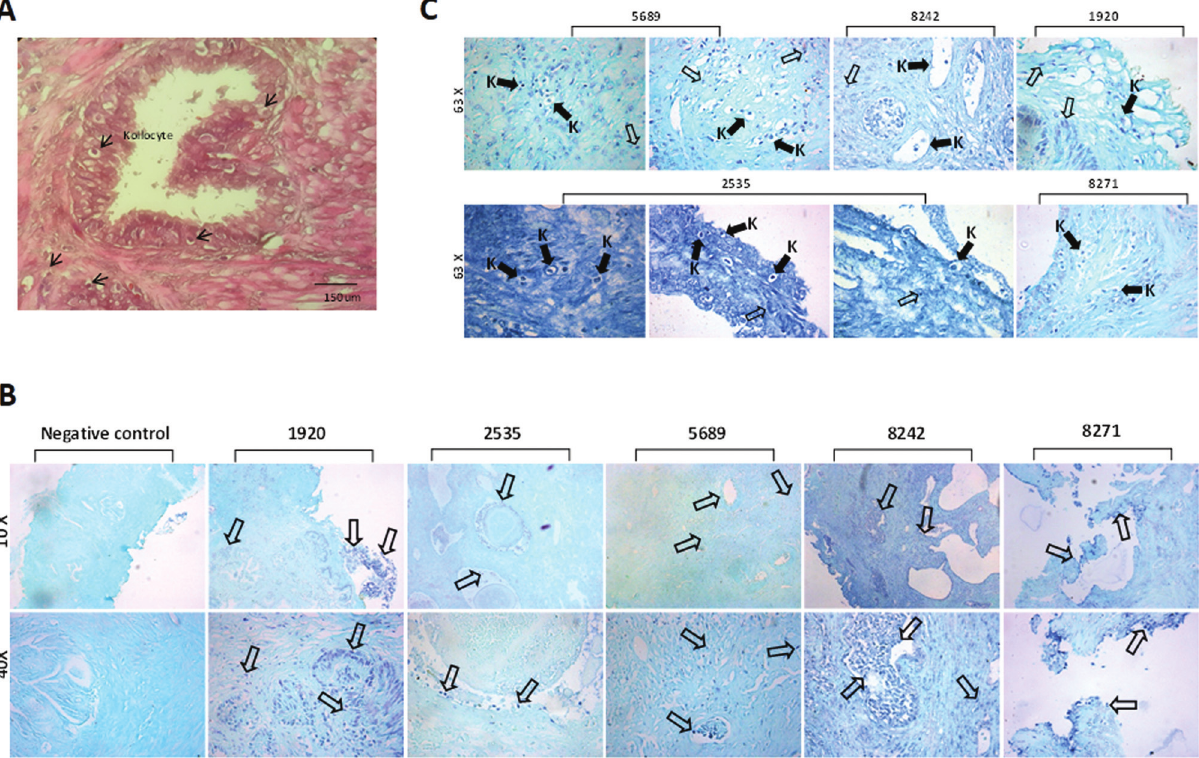
Figure 2 - Histopathological and molecular analysis of prostate cancer tissues. (A) Koilocytes were observed in several HPV-infected prostate cancer tis- sues. Arrows indicate the koilocytes in a representative image. (B) In situ HR-HPV detection. HR-HPV E6/E7 DNA was detected in prostate cancer sec- tions employing in situ PCR as indicated in the Materials and Methods. The signal was mainly nuclear (indicated by empty arrows). Magnification: 10 (cid:2) and 40 (cid:2) . (C) Solid arrows indicate a positive signal of HPV DNA amplification in koilocytes (K). Magnification: 63 (cid:2) . The numbers indicate the control number of each patient. Negative control: no forward primers were added for in situ